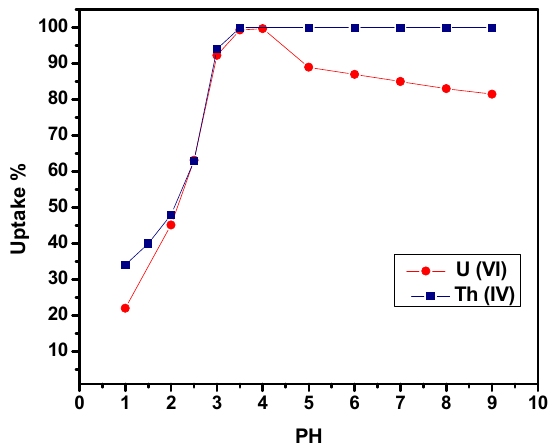
Figure 7. Effect of pH on U(VI) and Th(IV) ions sorption onto HQ-bentonite. Conditions: 0.1 g HQ- bentonite; 50 mL solution; 100 mg/L metal ion; shaking time U(VI) (15 min), Th(IV) (8 min); temperature 303 K.